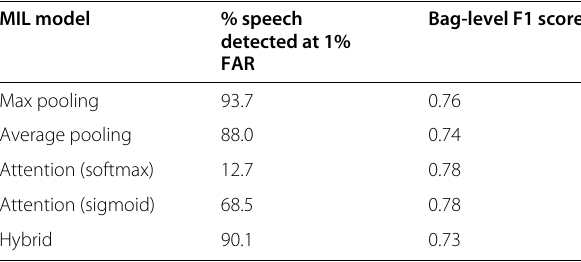
Table 4 Foreground localization results on frame (instance) level approaches on